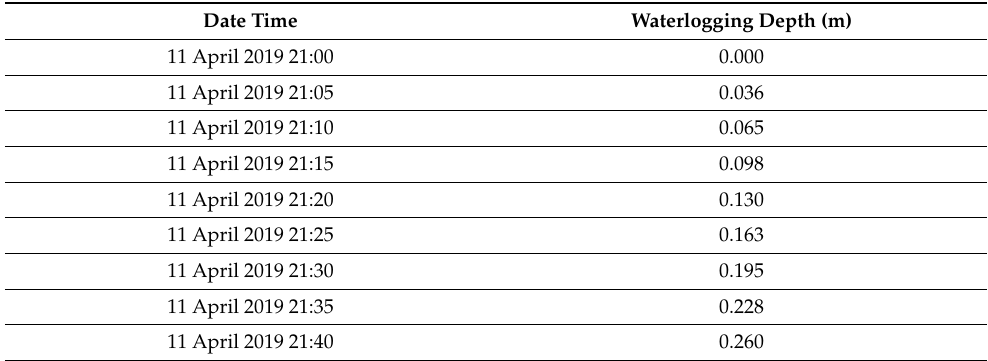
Table 8. Waterlogging data at monitoring station 106 in Futian District, 11 April 2019.